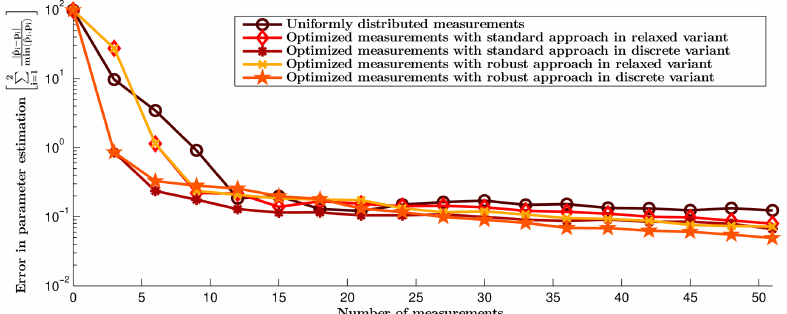
Figure 1. Averaged error in the parameter estimation from 10 optimization runs with the C 2 -model and three measurement per iteration with standard deviation 10 − 2 of the measurement error.